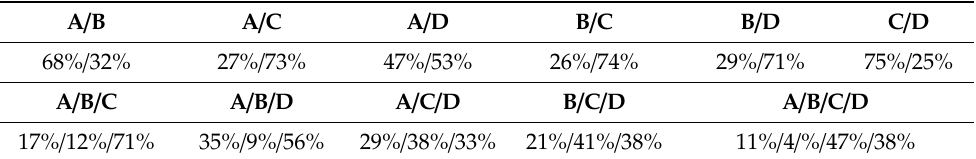
Table 7. Comparison of relative importance (RI) values in the ANN.